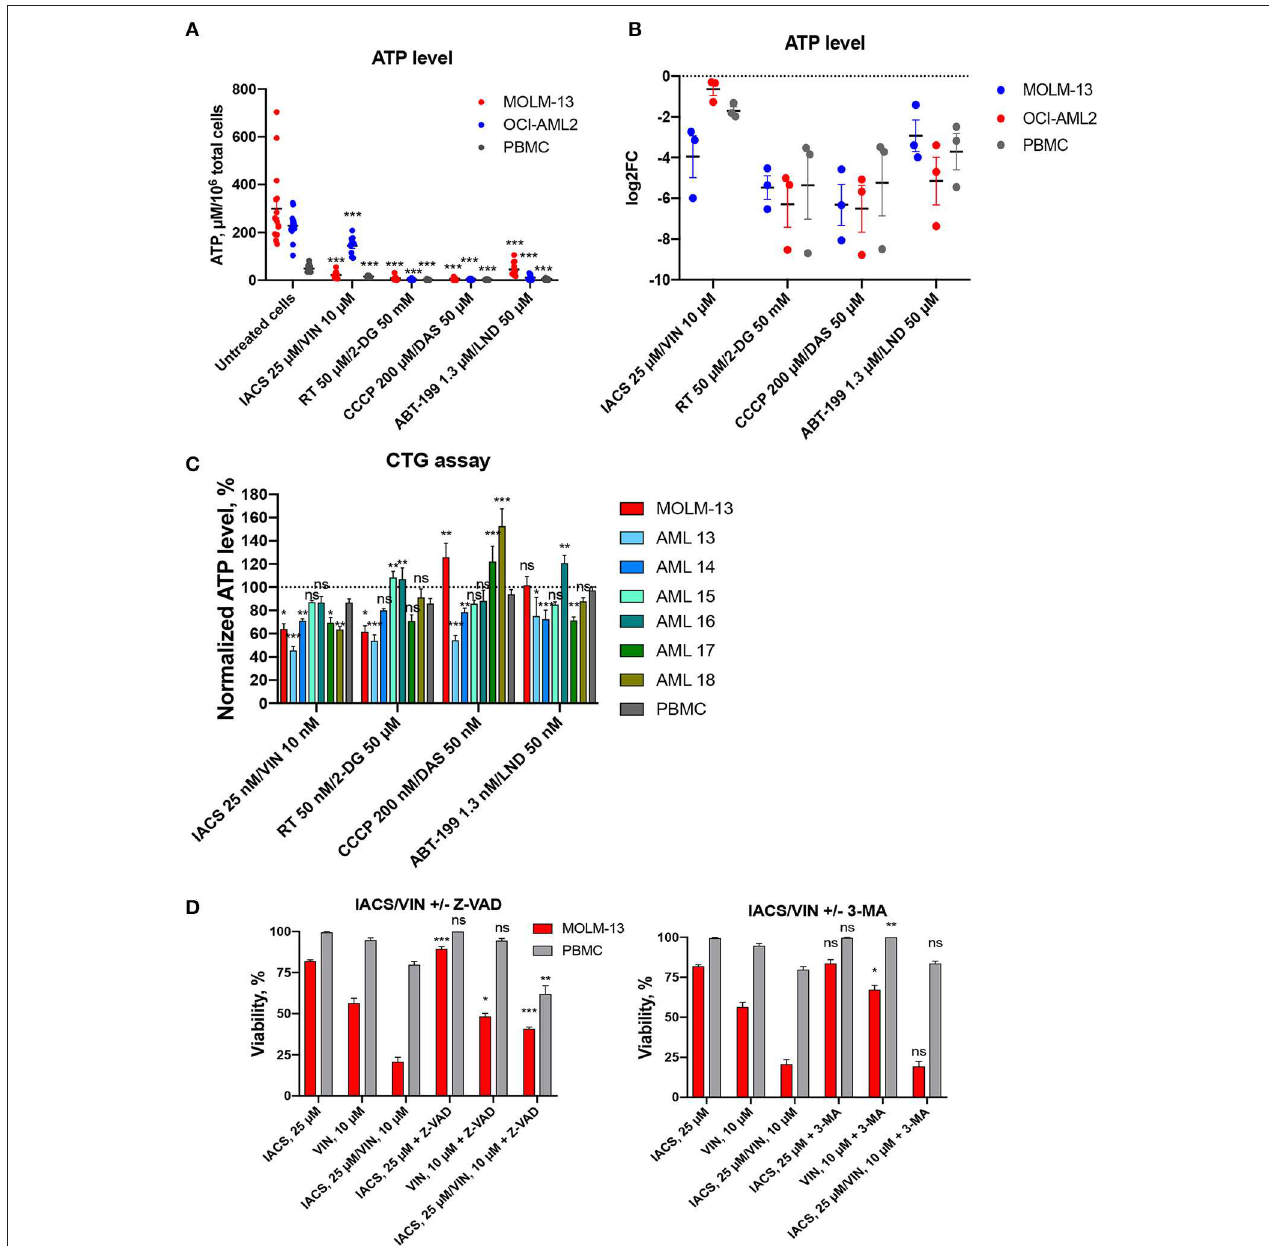
FIGURE 6 | Treatment-induced changes in ATP level and activation of cell death. Absolute (A) or relative (B) ATP levels following 16h treatment with DMSO or four selected drug combinations (IACS-010759/vinorelbine, rotenone/2-deoxy-D-glucose, ABT-199/lonidamine, or CCCP/dasatinib). Shown are mean ± SEM from at least three independent biological replicates. Significance of changes in ATP in treated vs. untreated cells for each cell line or PBMCs was assessed via Student’s t -test. *** p < 0.001. (C) ATP levels, obtained with CellTiter-Glo R assay and normalized to DMSO control (shown as y = 100), following treatment for 2h with 1/1,000 doses corresponding to maximal selectivity of drug combinations in AML cells (MOLM-13 or primary AML samples), or healthy PBMCs. Shown are the means from 1 to 3 independent biological replicates (mean ± SEM). Significance of difference in AML vs. PBMCs was assessed via Student’s t -test. (D) Changes in cellular viability after IACS-010759/vinorelbine or corresponding single drug treatment with or without addition of cell death inhibitors: Z-VAD, 40 µ M, left; 3-MA, 5mM, right. Shown are the means from three independent biological replicates (mean ± SEM). Significance of difference in survival with and without inhibitor was assessed via Student’s t -test. *** p < 0.001; ** p < 0.01; * p < 0.05; ns: p > 0.05. cytotoxicity seen in MOLM-13 cells exposed to IACS-010759 treated with individual compounds. After treatment, cell viability or the combination of drugs. This suggests that IACS-010759 was assayed using the Hoechst/PI co-staining method. Z- activates a mitochondria-dependent apoptotic cell death VAD-FMK, the pan-caspase inhibitor, significantly reduced the